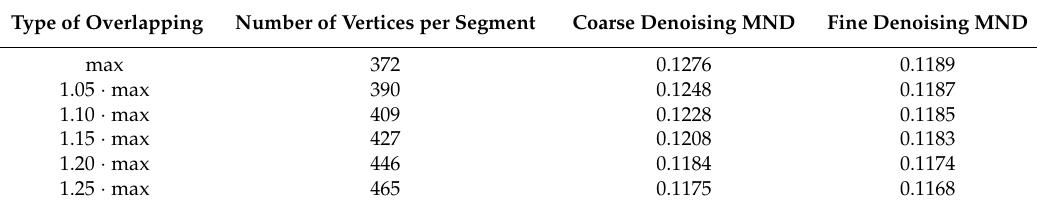
Table 4. Mean normal difference using different size of equal-sized overlapped submeshes (Julio Model with 36,201 vertices 100 segments).